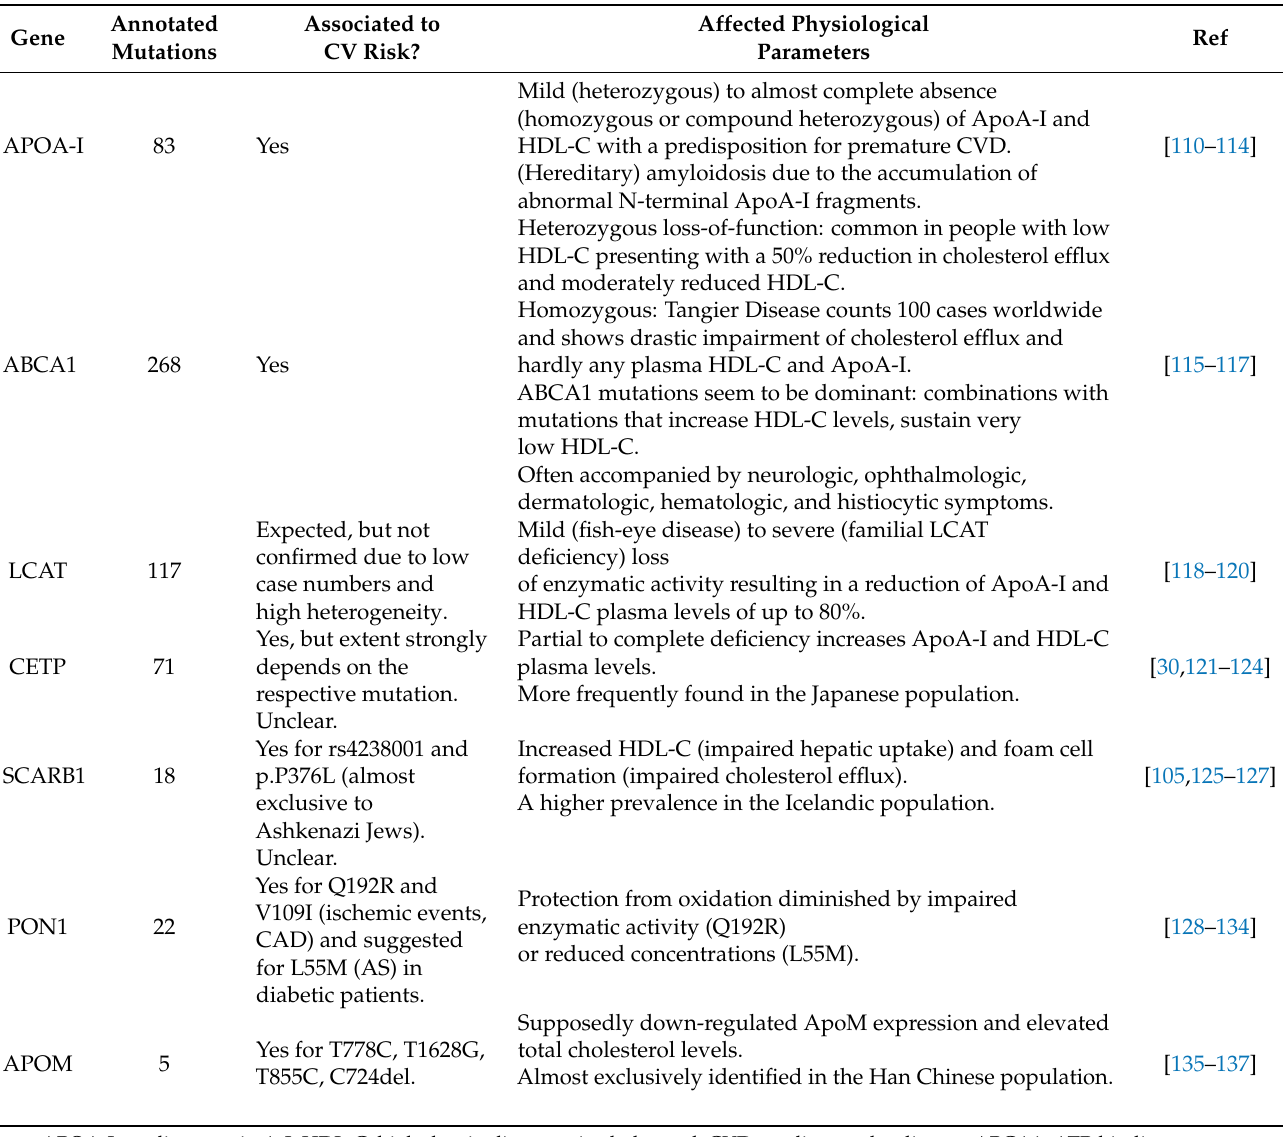
Table 2. Genetic alterations in HDL metabolism-associated